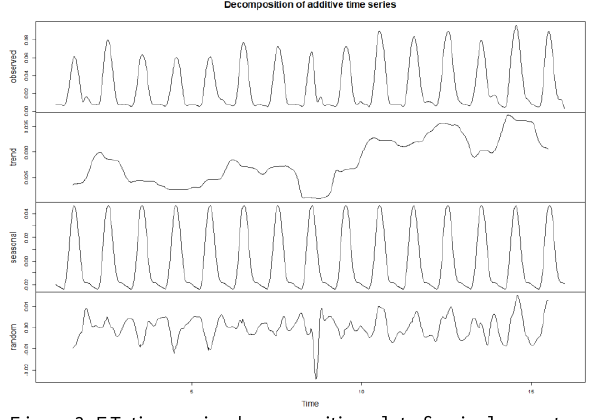
Figure 3. ET time series decomposition plot of a single genotype (as an example) representing the observed, trend, seasonal and random series (in the order of top to bottom).